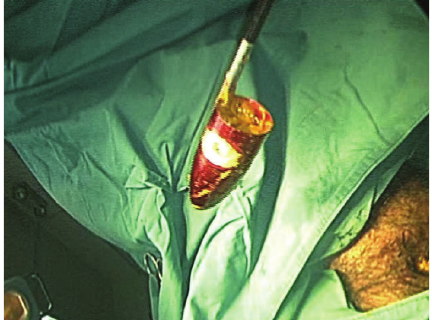
Figure 4: In order to retrieve the object, a straight 35 mm laparo- scopic grasper was introduced into the lumen and advanced under laparoscopic vision (arrow) in order to avoid iatrogenic injury to the mucosa.